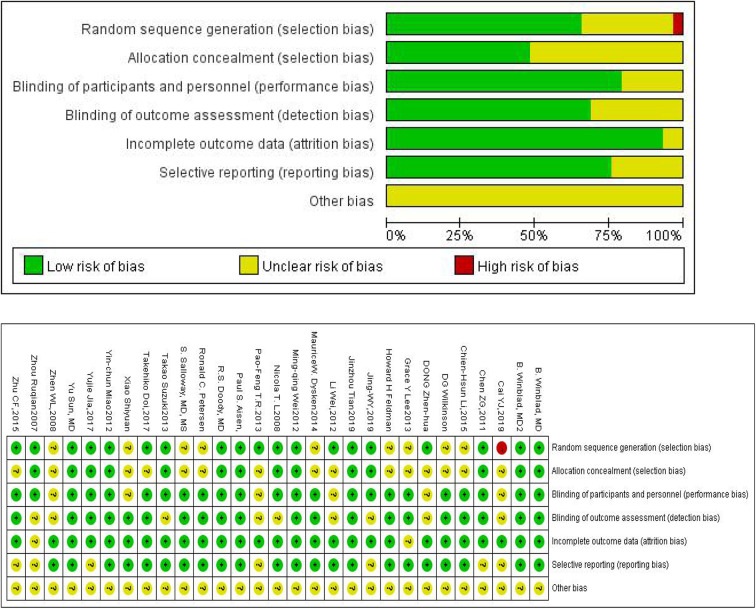
Quality assessment of included studies.